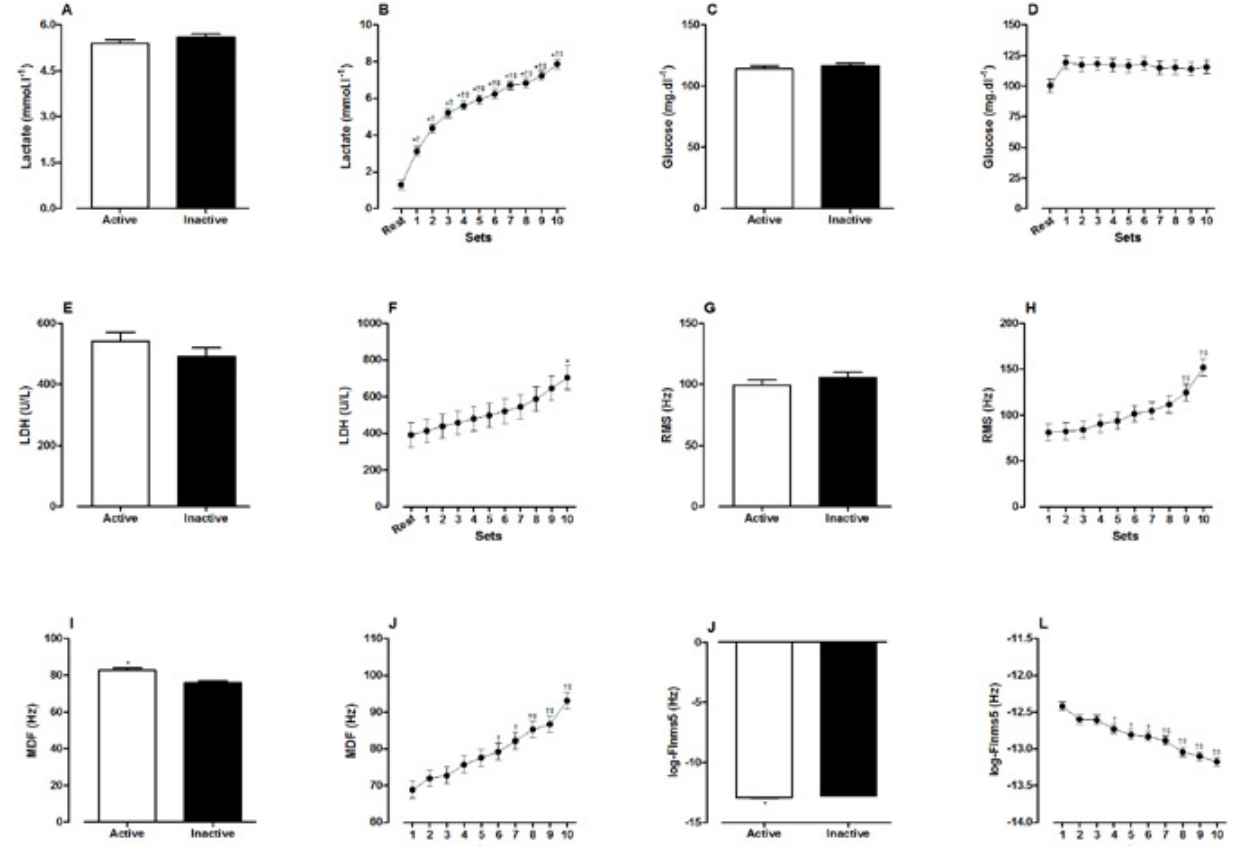
Figure 2. Values expressed in mean ± standard deviation in pre-exercise (0), and at the end of each set of 10 repetitions in the knee extension isokinetic exercise, between active and inactive subjects. Panels A and B: lactate concentration. Panels C and D: glucose (C and D) Panels E and F: lactate dehydrogenase. Panels G and H: root-mean-square (RMS). Panels I and J: median frequency (MDF). Panels L and M: log- FInsm5